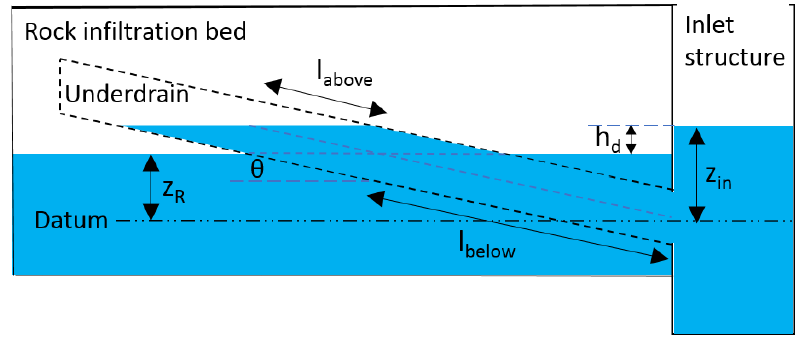
Figure 7. Profile view of a typical distribution system in this research.